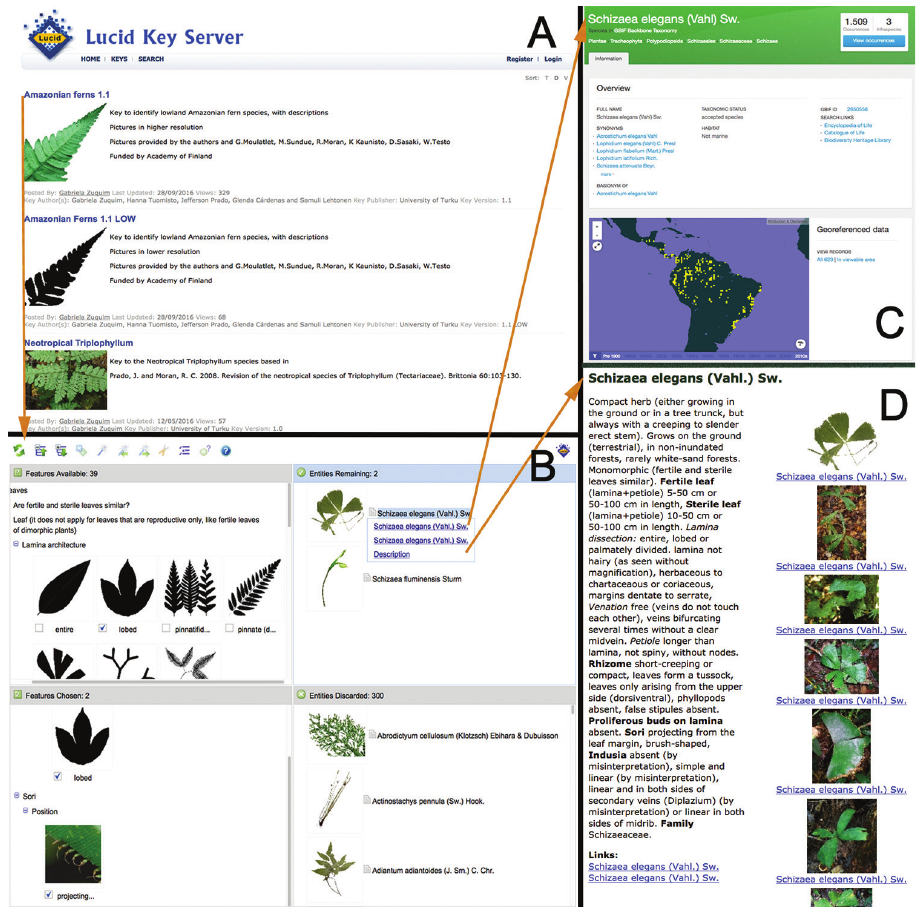
Figure 3. Available contents of the online fern keys. Screenshots of the online key. A Entrance page with a list to all available keys B an overview of the key after two features have been scored, (C) link to pos- sible identification occurrence map in GBIF D description of the entity that possibly matches the plant needing